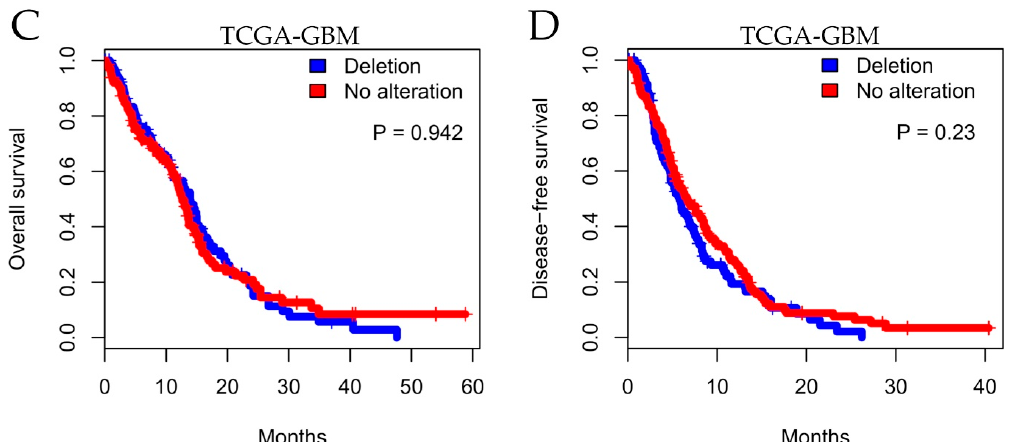
Figure 4. Kaplan–Meier analysis for MTAP expression associated with patient survival. Overall survival for a series of patients with glioma diagnosis according to histopathological grade. Shown for ( A ) adult glioblastoma, ( B ) pediatric glioblastoma, and ( C ) TCGA-GBM dataset status and ( D ) five-year disease-free survival (DFS) for TCGA-GBM